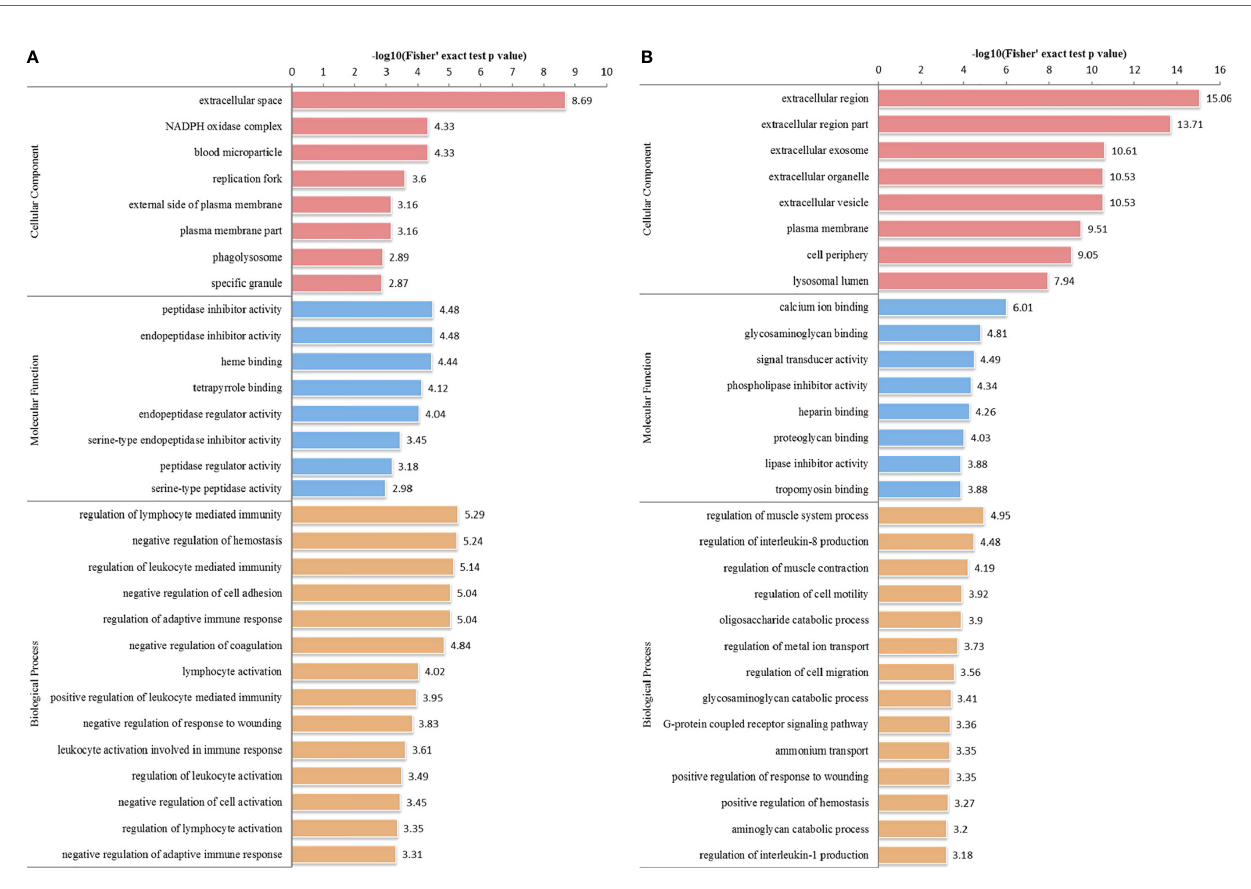
FIGURE 4 | GO distribution of DEPs in the HT vs . H group. The enriched GO terms under cellular component, biological process, and molecular function classi fi cations for (A) upregulated and (B) downregulated